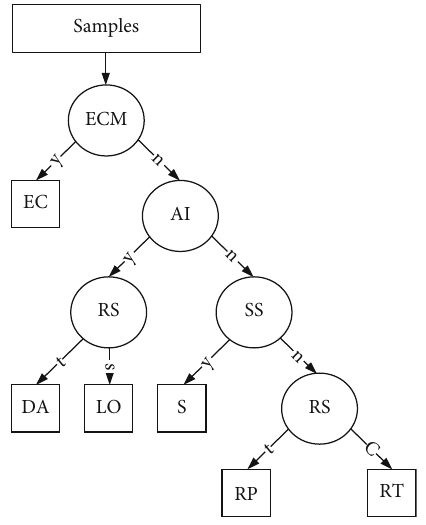
Figure 16: An example of decision tree for general tactical intention recognition. The characters in the circle represent the features that are distinguished by the node, and each identi fi cation inputs the result into the corresponding child nodes. Arrows represent the identi fi cation process. The letters on the arrow represent the attributes of the feature. Small squares represent the attributes of leaf nodes, and the presence of small squares indicates that the division of branches has been